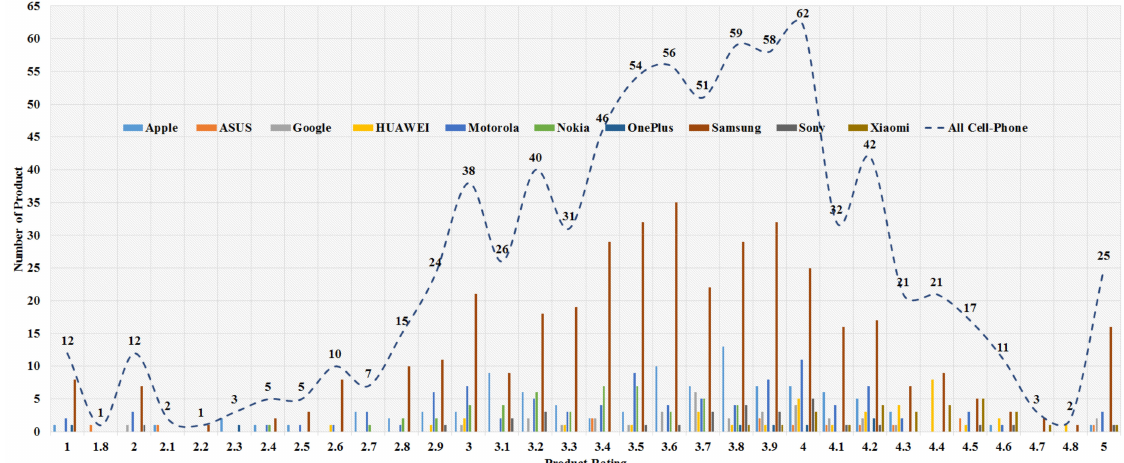
Figure 6. Brand wise and rating wise number of products in the market for review.